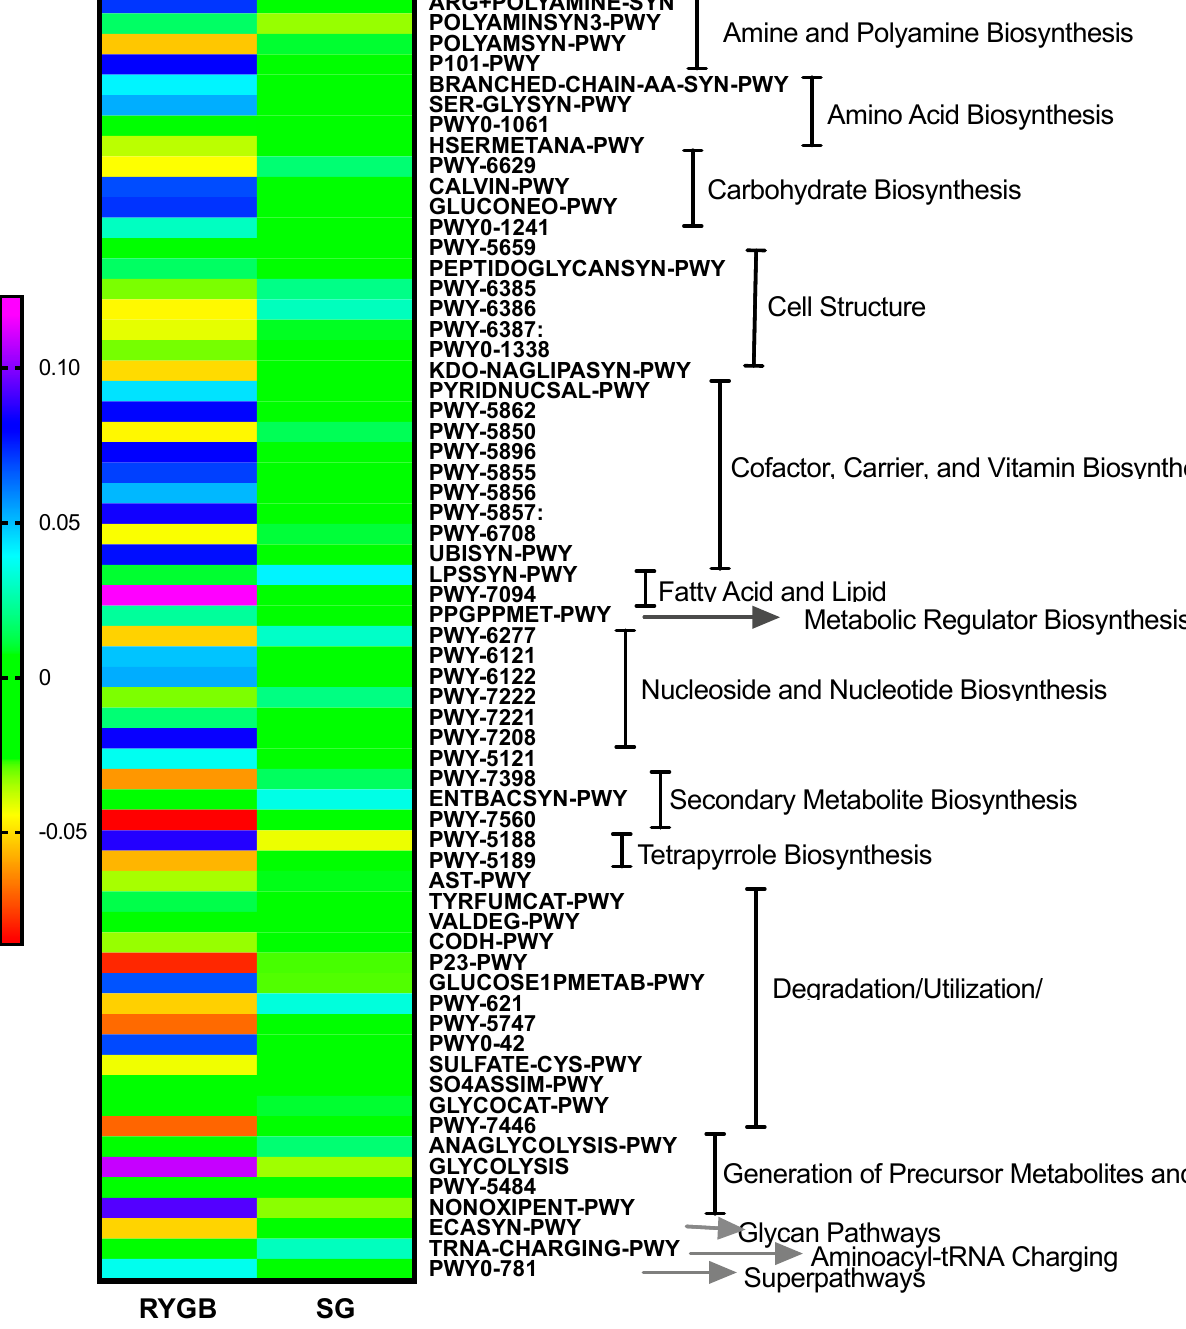
Figure 4. Heatmap of the changes in the metabolic pathways inferred by a Picrust analysis of the 16S rRNA sequences. Metacyc pathways of interest are depicted, as well as their super-classes of entity. Additional information about each pathway-ID can be found in the Supplementary Table S1 in Supplementary Material.